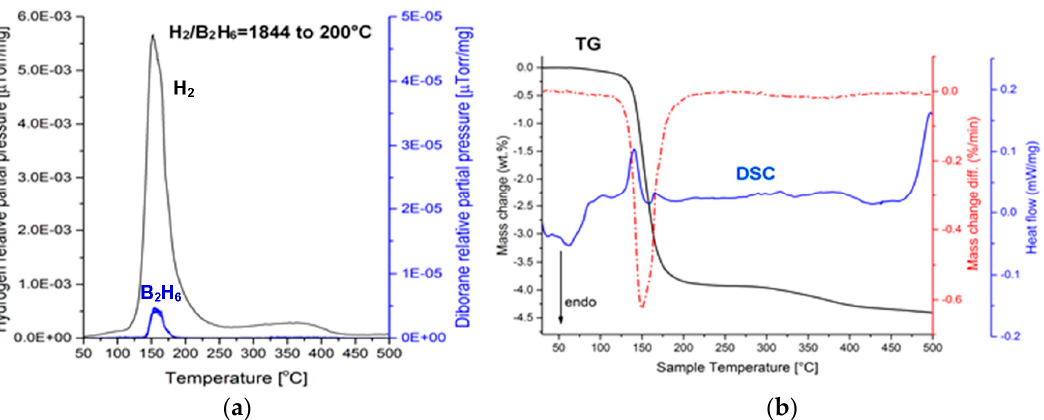
Figure 3. ( a ) Mass spectrometry (MS) (gas desorption spectra) of a (H 2 + B 2 H 6 ) gas mixture for a ((2NaBH 4 + MnCl 2 ) + 5 wt. % graphene) sample, ball milled (BM) for 0.5 h (Q TR = 36.4 kJ/g). ( b )